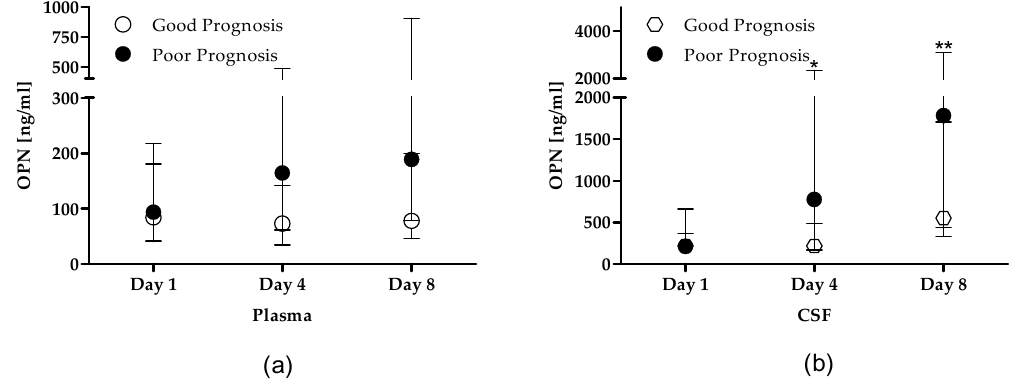
Figure 2. OPN levels stratified by prognosis. OPN levels assessed in 7 patients with good prognosis (open circle) and 37 with bad prognosis (solid circle) in ( a ) plasma samples and ( b ) CSF samples. Data are expressed as median and interquartile range. * p < 0.001 vs. day 1, ** p < 0.0001 vs. day 1 in CSF samples, Wilcoxon matched-pairs signed rank test. Abbreviations list: OPN: osteopontin; CSF: cerebrospinal fluid.